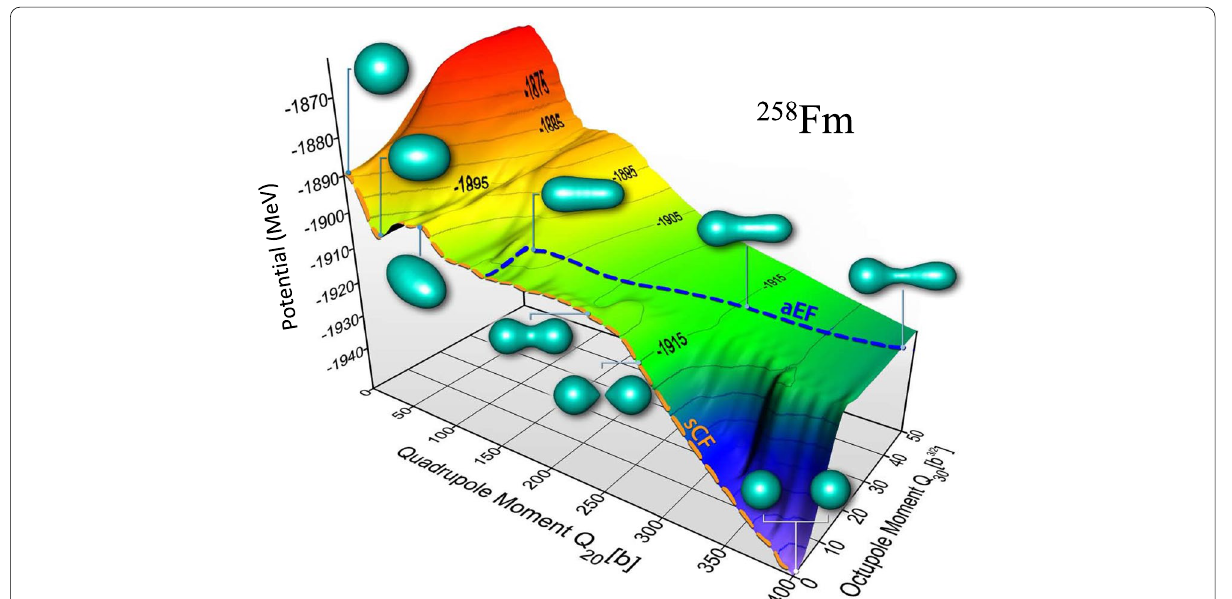
Fig. 5 Potential energy surface of 258 Fm calculated along quadrupole (Q 20 ) and octupole (Q 30 ) mass moments. Symmetric compact fission (sCF) and asymmetric elongated fission (aEF) paths are drawn using dotted lines. Nuclear shapes along these paths are shown for specific values of Q 20 and Q 30 as indicated. The figure adapted from (https:// people. nscl. msu. edu/ ~witek/ fissi on/ fissi on. html)